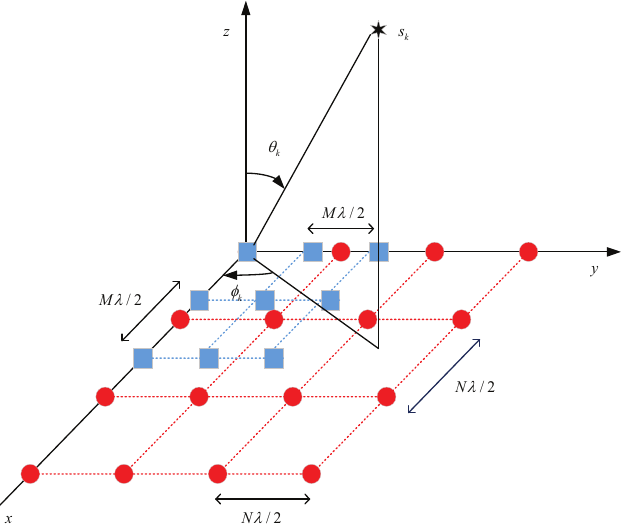
Figure 1. The configuration of the co-prime planar array with M = 2 and N = 3, where the red elements represent the array elements of the first planar sub-array, and the blue elements represent the array elements of the second planar